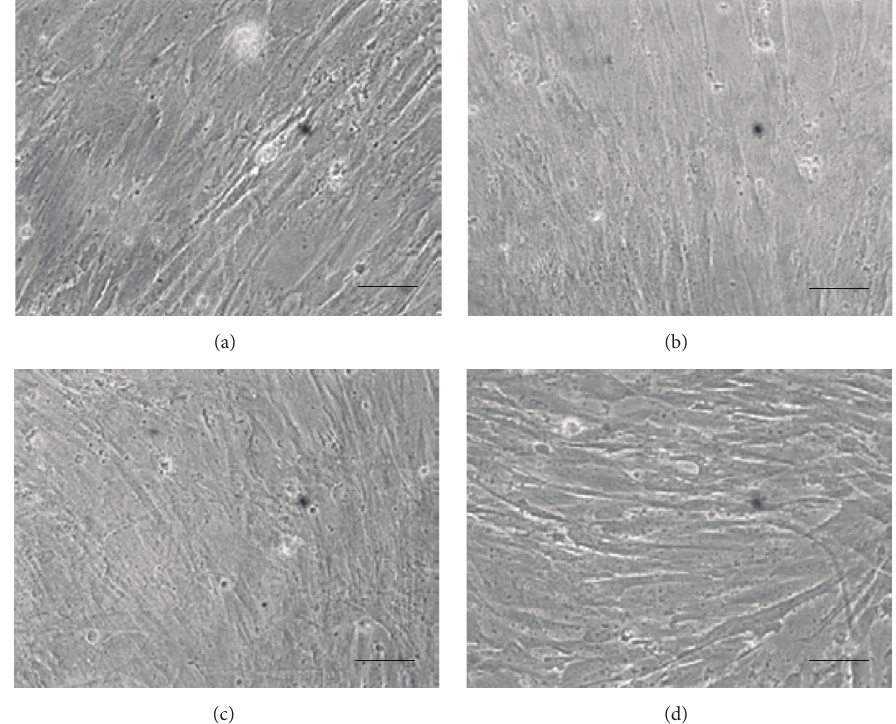
Figure 5: Photomicrography of BM-MSC. Cells cultivated for eight days in medium supplemented with 10% FBS (a) or a pool from four donors of 5% PRPr obtained from collection tubes containing EDTA (b), SC (c), or ACD (d). Phase contrast, 200x magnification, and scale bars: 50 𝜇 m.